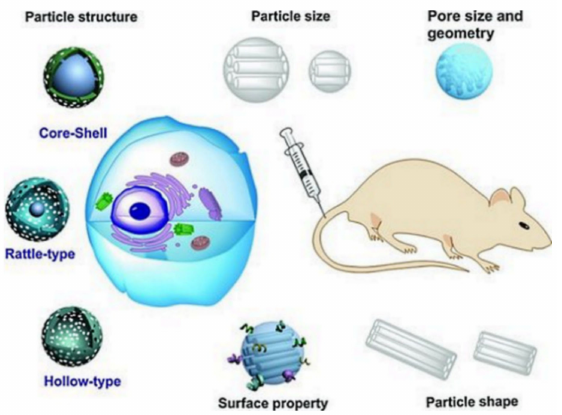
Figure 9. Schematic illustration of the biocompatibility and biotranslocation of MSNs and the main physical–chemical characteristics. These highly influence the cellular uptake, intracellular translocation, and cytotoxicity on the in vitro level, and the biodistribution, biodegradation, excretion, and toxicity on the in vivo level. Reproduced with permission from [131], WILEY-VCH Verlag GmbH and Co. KGaA,